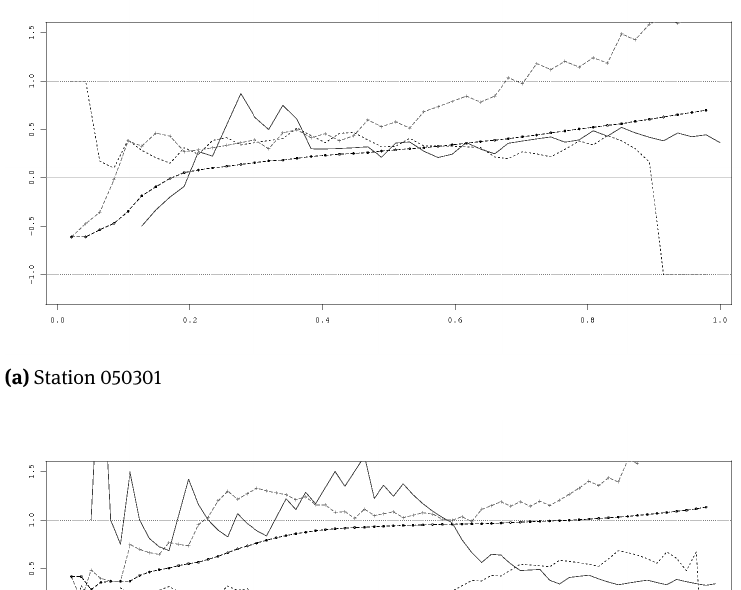
and 4c do not allow to conclude since the tail dependence estimators do not satisfy (ˆ¯ χ (ˆ¯ χ = 1, ˆ χ ∈ (0, U U